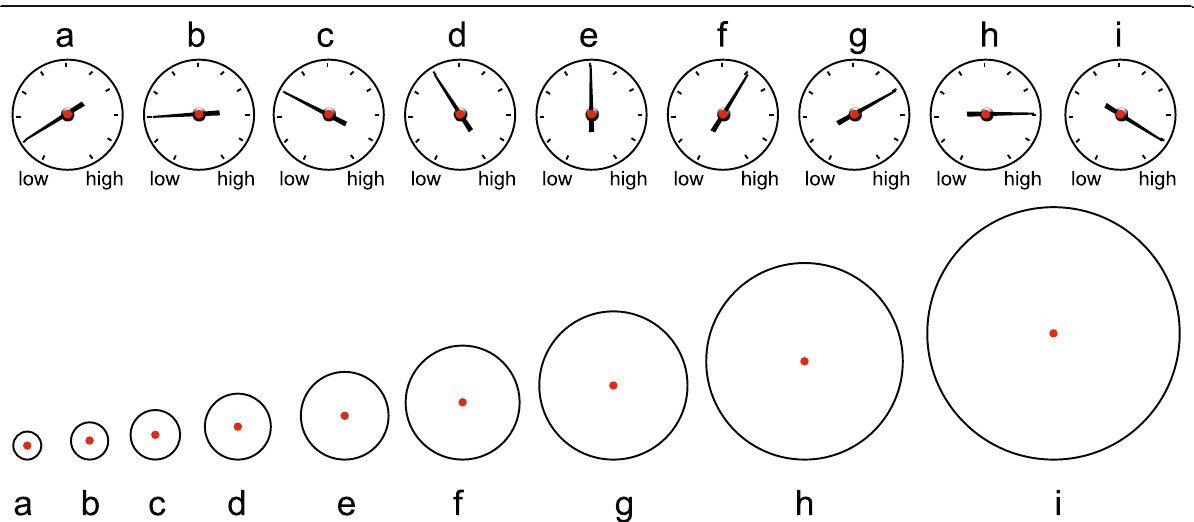
For the intensity task, the scale was indicated by gauges, and for the size task the scale was indicated by circles (Fig. 4). Each circle was scaled by 30% from the prior cir- cle. Each gauge was scaled by 1 ‘ tick ’ from the prior gauge.